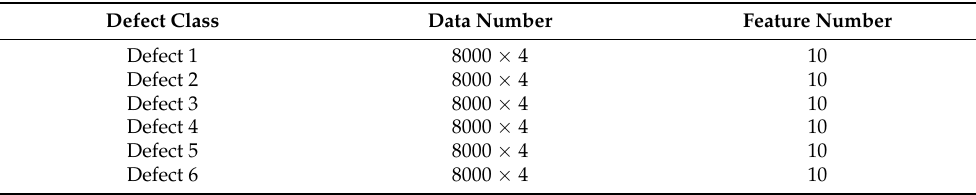
Table 2. Wire rope inspection data from four different datasets.